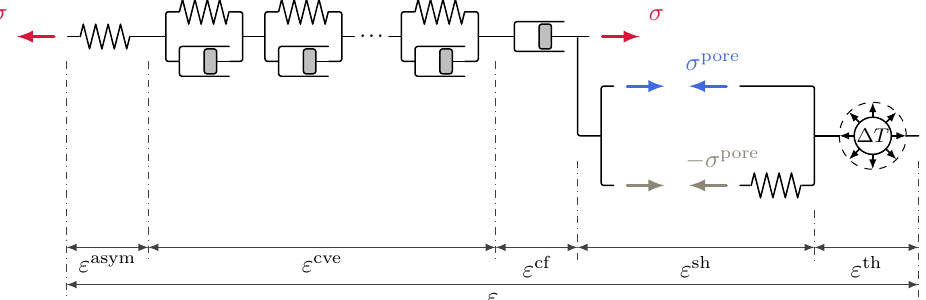
Figure 3. Schematic representation of the multiphase shrinkage and creep formulation in terms of total stress; viscous flow and viscoelastic creep are driven by total stress, shrinkage by the pore fluid stress